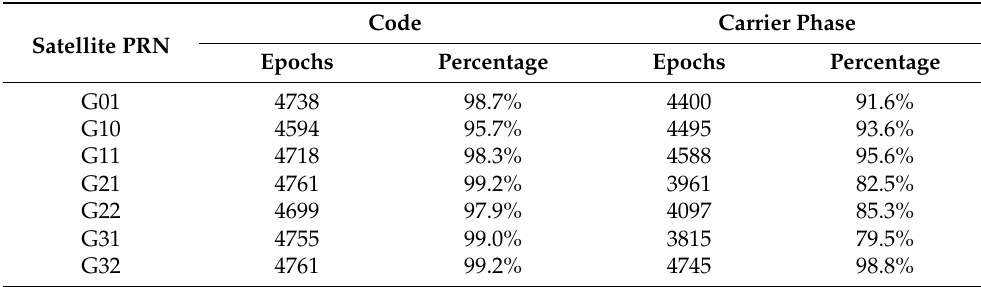
Table 1. Number of epochs of the code and carrier phase observations, counted per satellite, and the corresponding percentages relative to the total